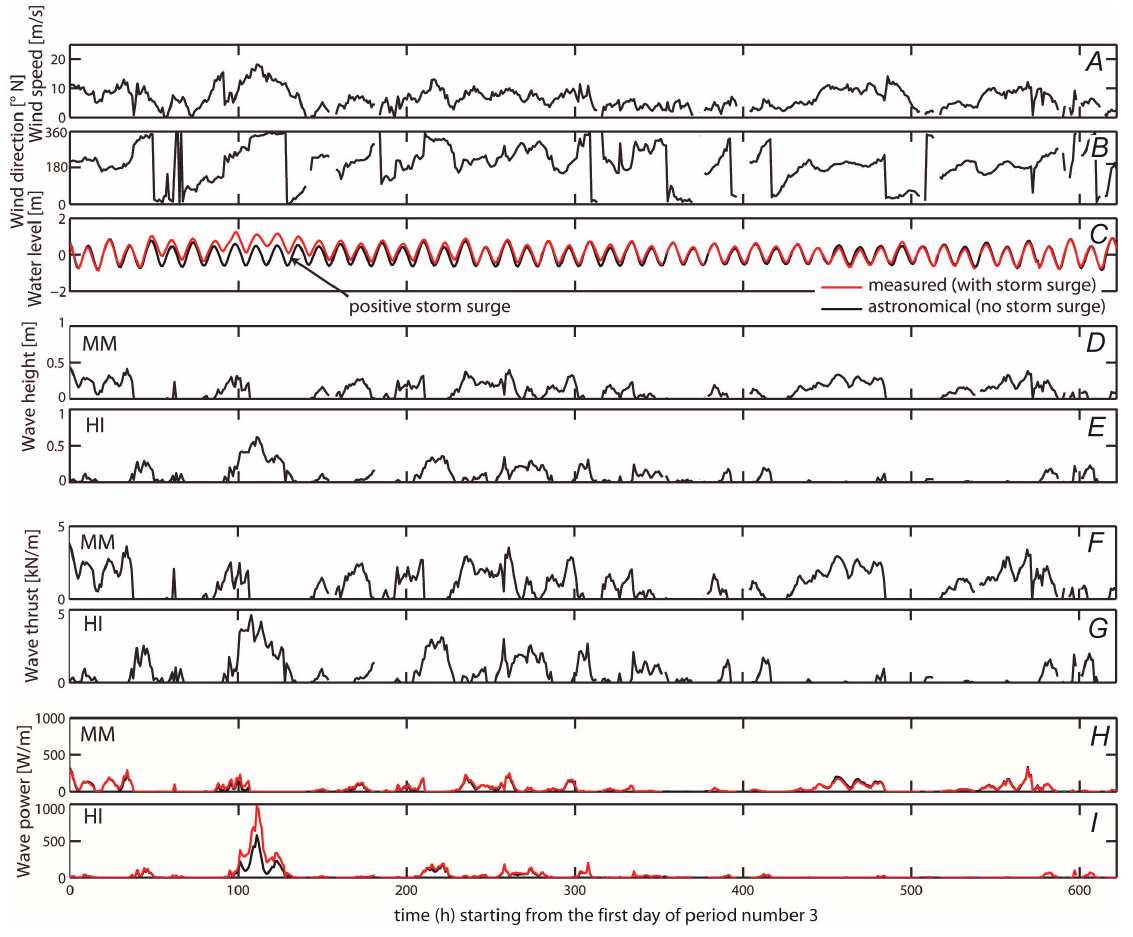
Figure 6. Sample time series reconstruction (21 August 2008 to 13 April 2010) of modeled wave height, wave thrust, and wave power using measured (with storm surge) and predicted (no storm surge) water levels for two study sites. The full reconstruction for data analysis spans from 1 April 2002 to 19 April 2010 for all three study sites. Note peak wave power at the HI location ( t = 110 h) due to the storm surge, which is double the wave power without storm